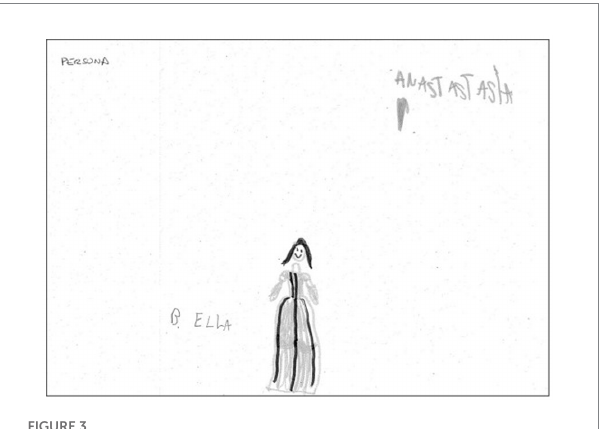
FIGURE 3 Subject 8: First drawing (female figure) of 7-year-old girl. CSA indicators: Indicator 2 (head detached from body), Indicator 4 (dot/ shaded eyes), Indicator 5 (hands cut off/omitted). T2F emotional indicators: Indicator 17 (shading of body), Indicator 18 (shading of limbs), Indicator 24 (poorly integrated figure) and Indicator 26 (hands cut